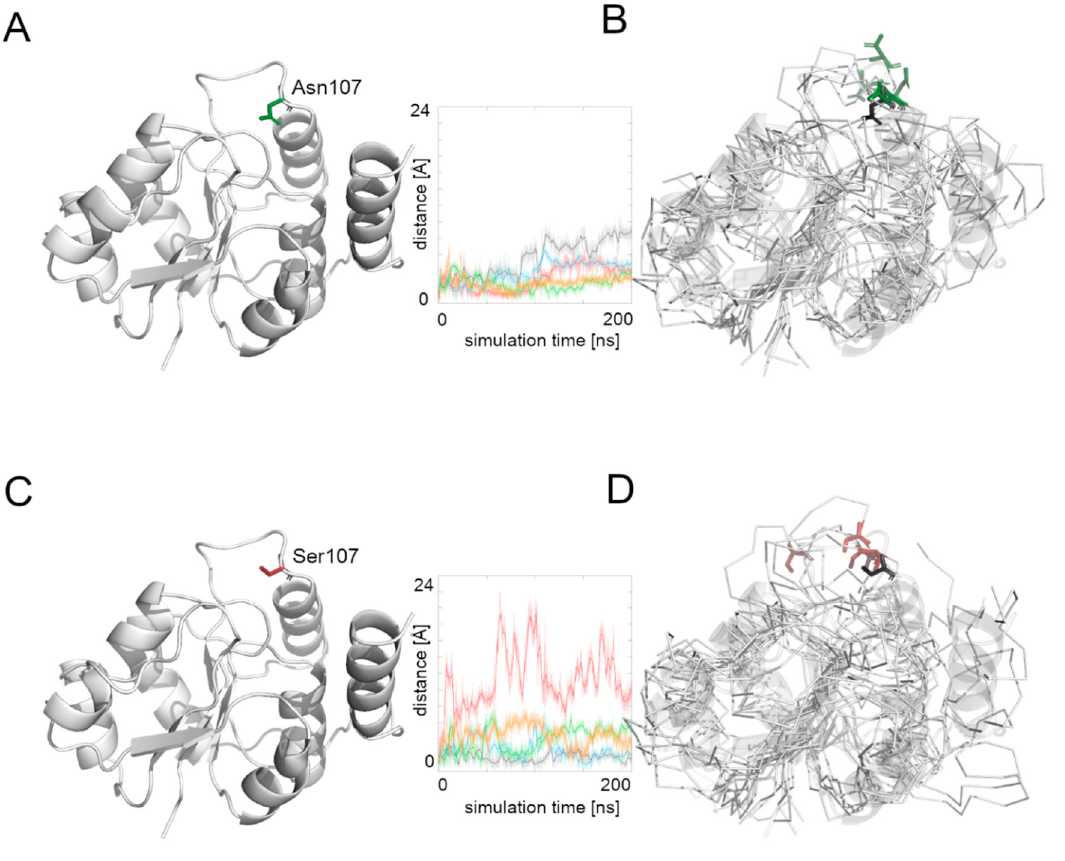
Figure 4. Comparison between the starting point structure of the human Alg13 model and the structures at the end of the simulation. ( A ) Native Alg13 protein structure, ( B ) a set of five structures at the end of the simulation of the native human Alg13, ( C ) Asn107Ser variant of the human Alg13 protein, ( D ) a set of five structures at the end of the simulation of the Asn107Ser variant of the human Alg13. The native Asn107 is colored green, and the Asn107Ser residue is red. The set of five structures at the end of the simulation are shown as ribbons, and the starting point structure (transparent cartoons and black sticks for the starting position of the 107 residue) overlaps with them. Distance plots show the distance between the starting position of 107 residue’s C α atom and its position in each simulation frame; each colored line represents one